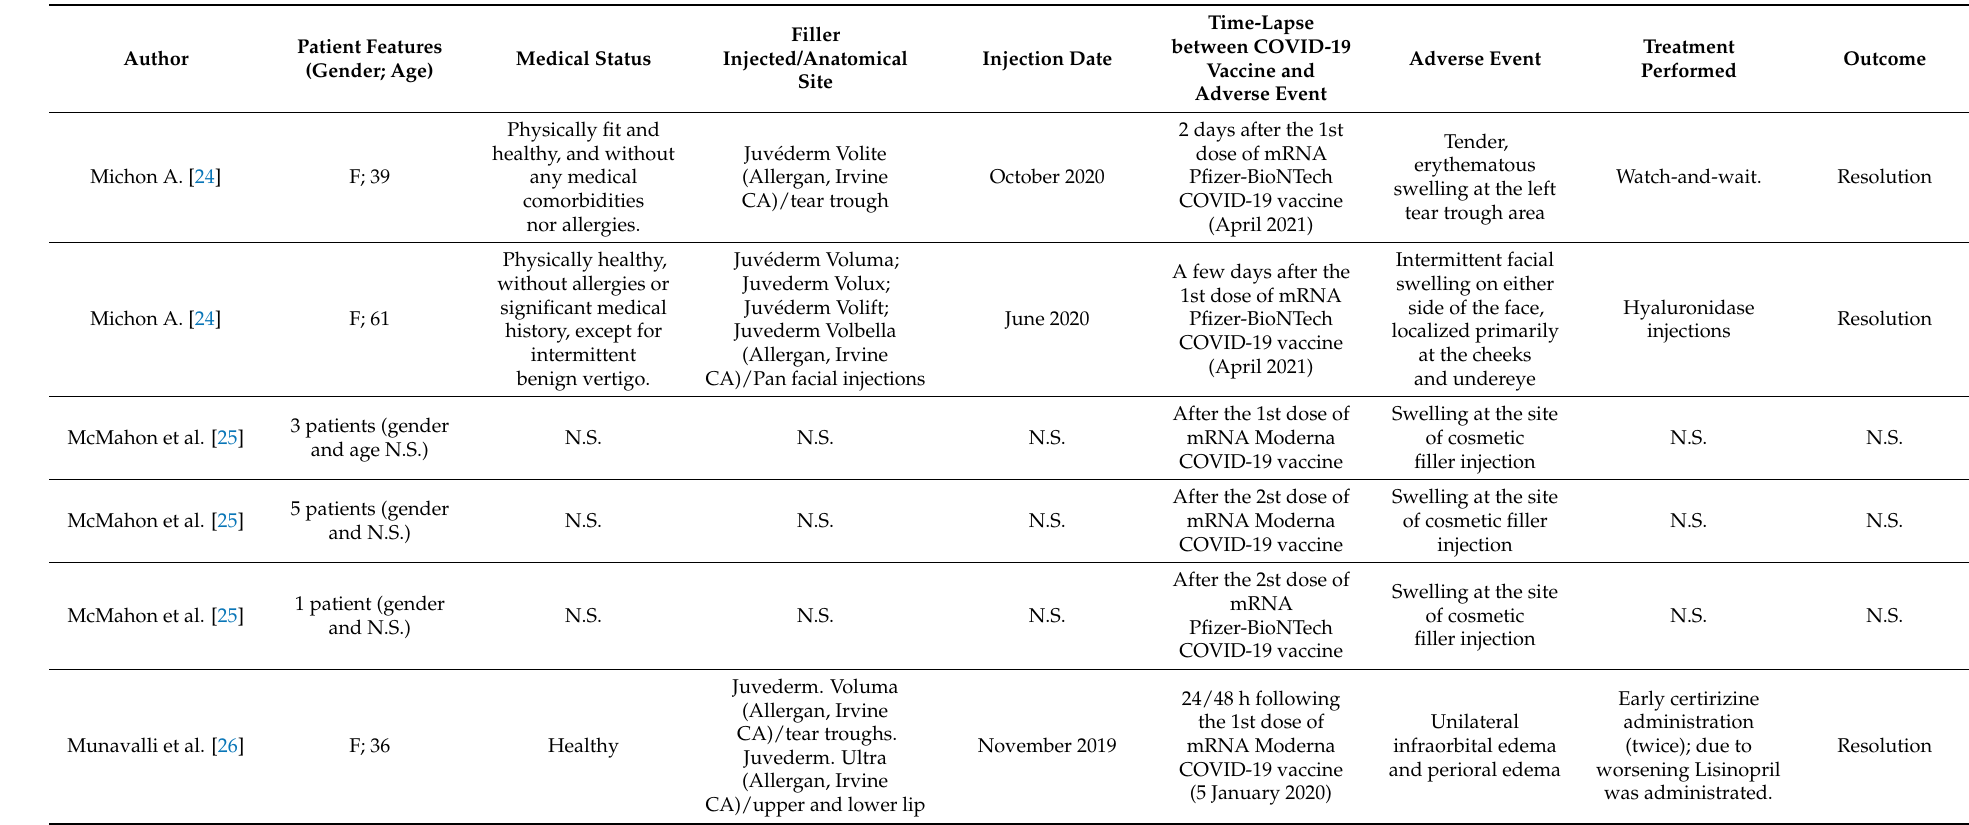
Table 1. Review results. Patients’